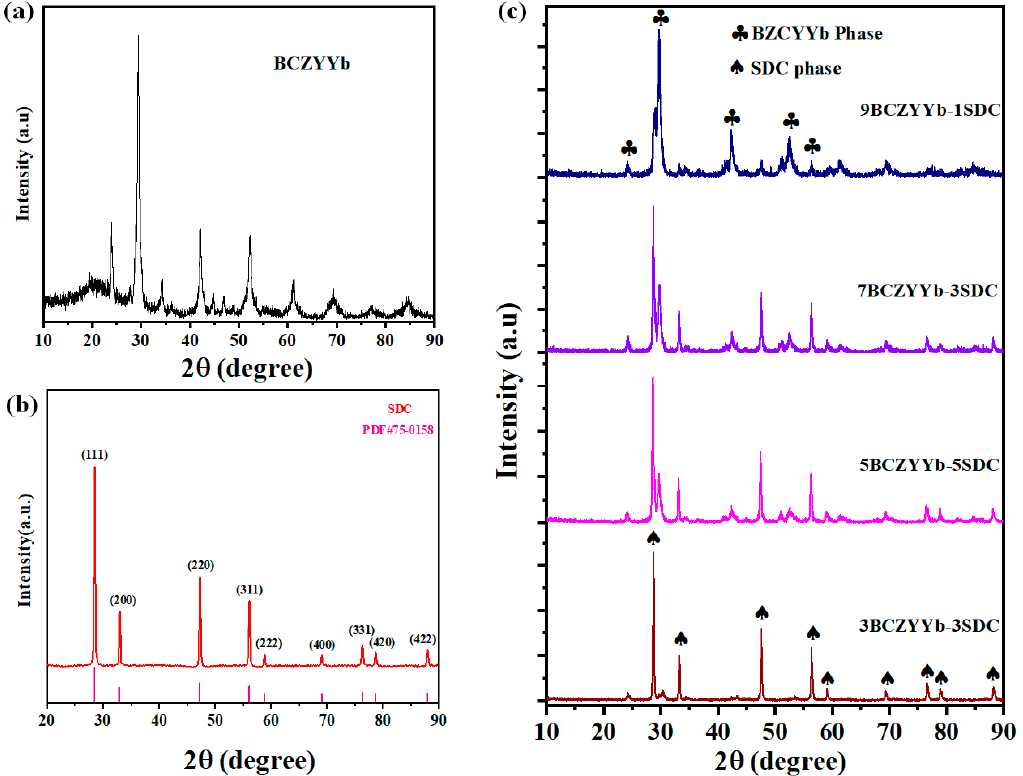
Figure 1. ( a – c ) X-ray diffraction patterns of synthesized BCZYYb, SDC and different heterostructures of BCZYYb-SDC heterostructures, respectively.